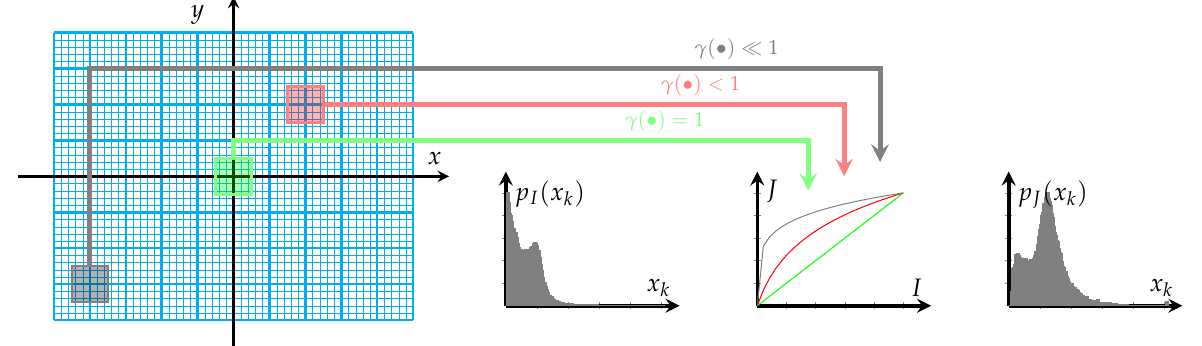
Figure 3. Overview of the proposed image enhancement depending on window spatial location.